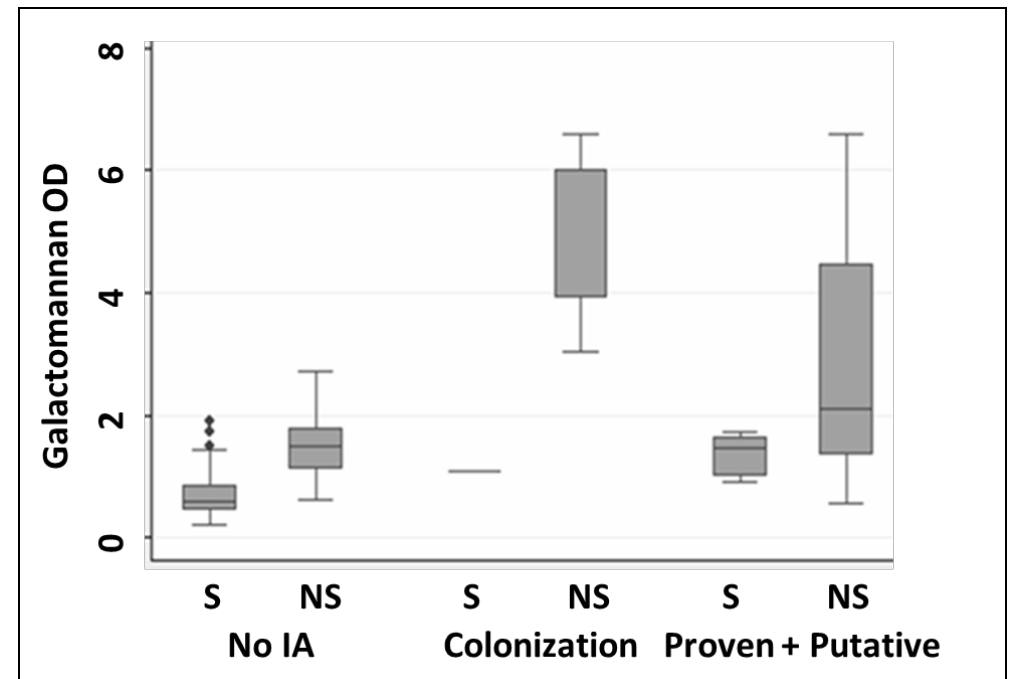
Figure 1. Boxplot characterization of the median galactomannan OD index values categorized using AspICU criteria.